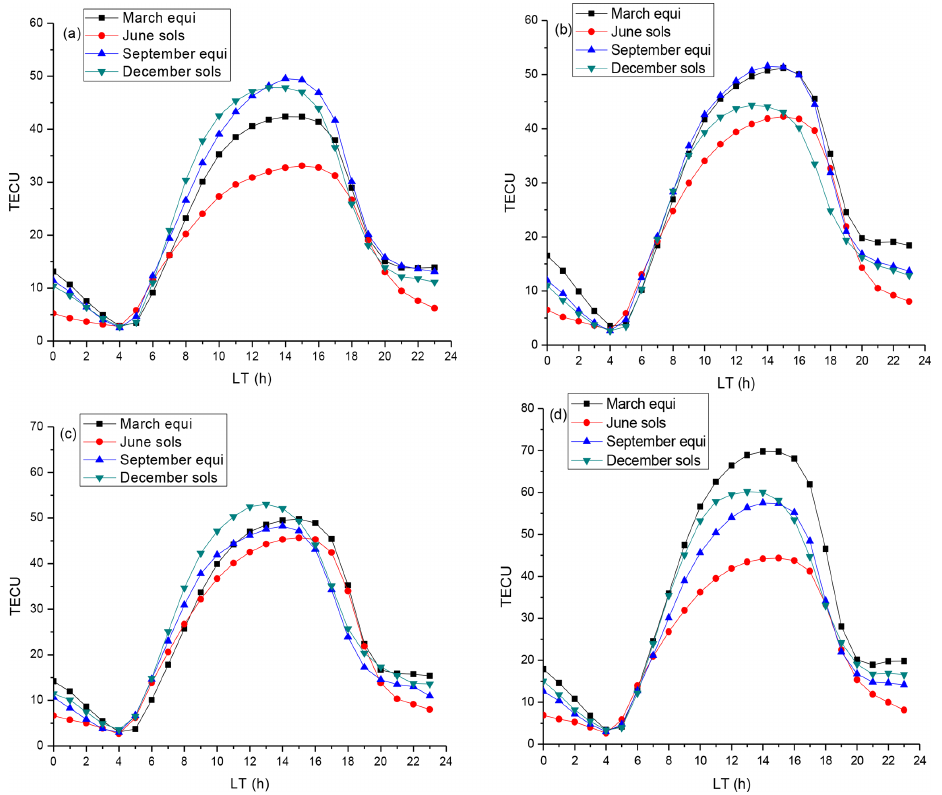
Figure 9. Seasonal variation in observed OBS-TEC during (a) 2011, (b) 2012, (c) 2013 and (d) 2014; equi stands for equinox and sols stands for solstice.